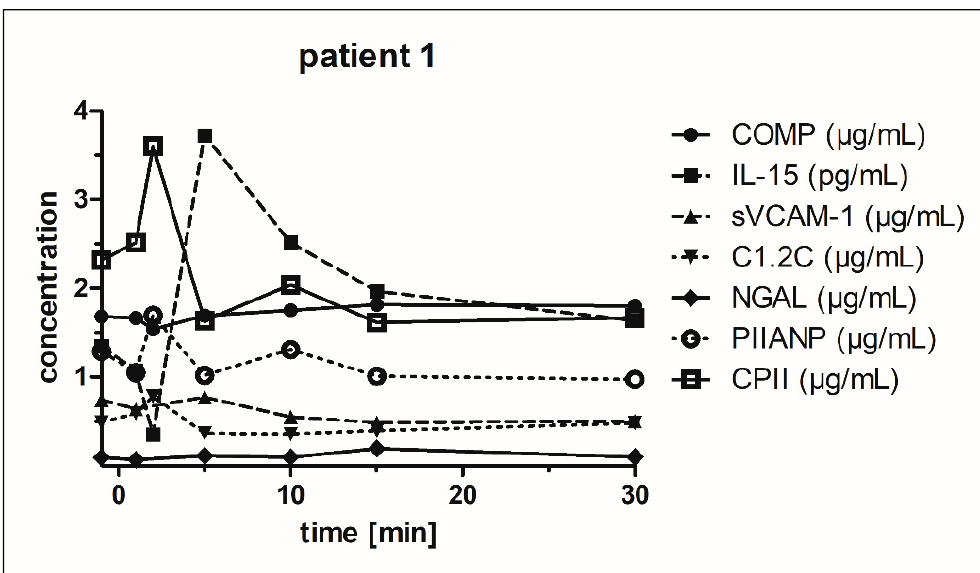
Figure 1. Time-dependent biomarker concentrations in the serum of a randomly selected osteoarthritis (OA) patient. The biomarker concentrations are shown before (t = − 1 min, baseline) and after exercising of the hand and finger joints. The values at baseline are shown together with the y-axis at − 1 min.